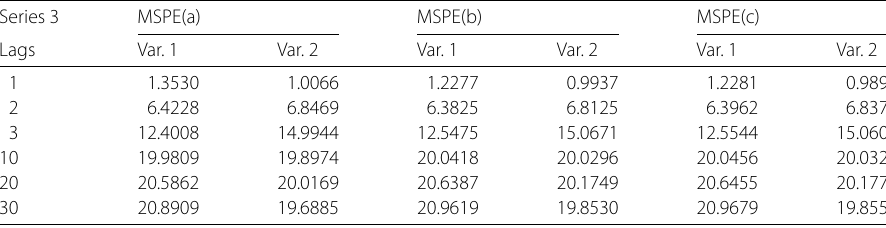
Table 3 Model NPAR(1) with VAR(3) noise (Series 3)